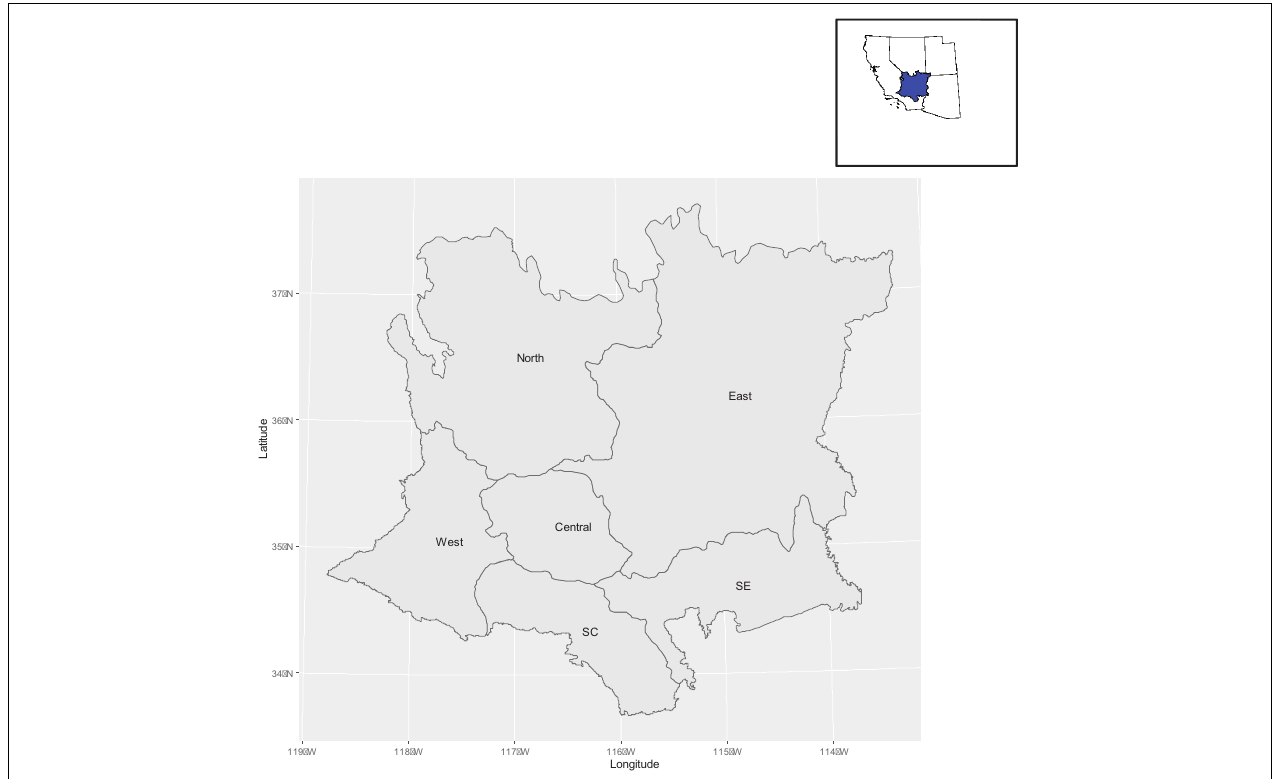
FIGURE 1 | The Mojave Desert of North America. SE, southeastern subregion; SC, southcentral subregion.